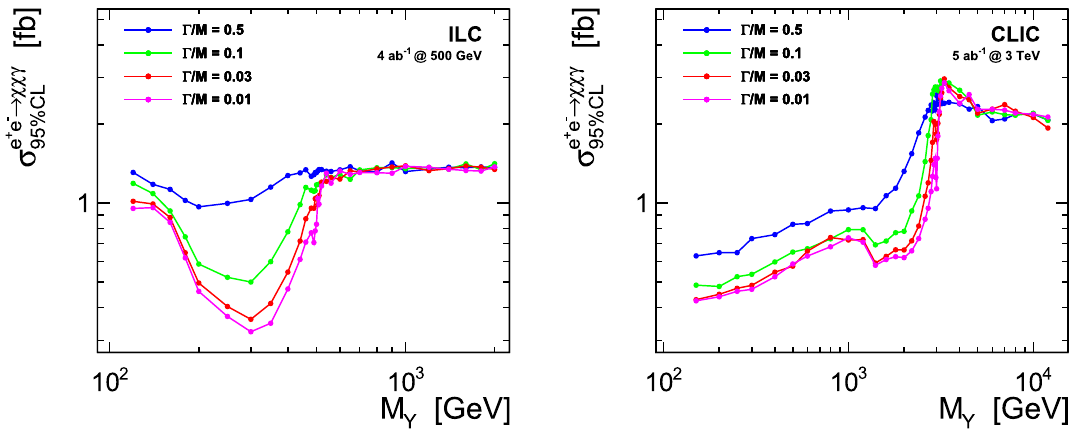
Fig. 11 Limits on the cross section for the radiative DM pair-production processes with s -channel vector mediator exchange for the ILC running at 500GeV (left) and CLIC running at 3TeV (right) and different fractional mediator widths, as indicated in the plot. Combined limits corresponding to the assumed running scenarios are presented with systematic uncertainties taken into